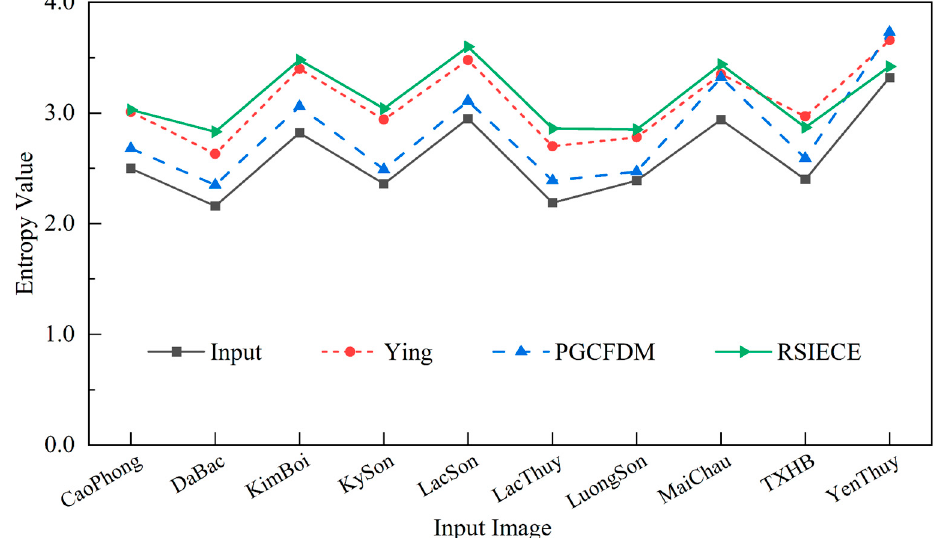
Figure 6. Comparison of the quality of the enhanced images by the RSIECE algorithm with that of the Ying and PGCFDM methods in terms of the entropy index.